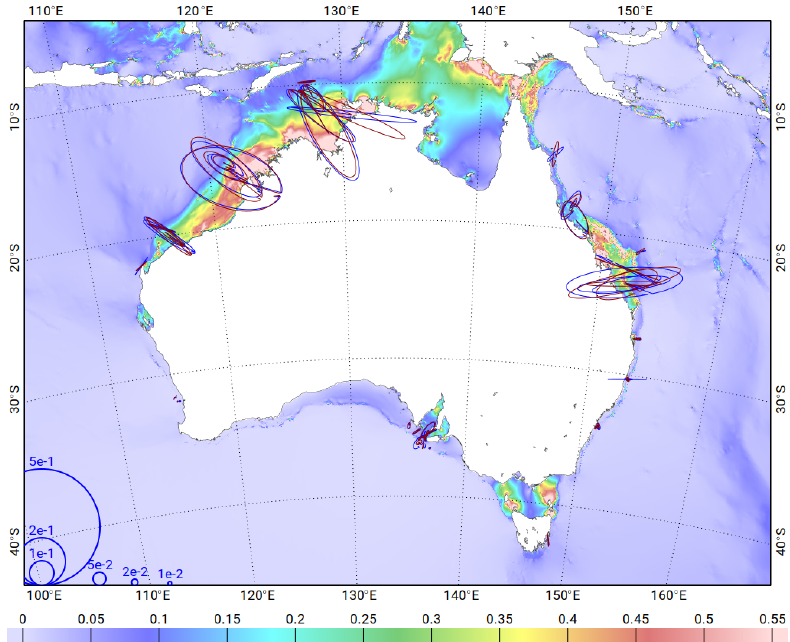
Figure 18. M2 tidal component, tidal velocity ellipses at the 48 current meter stations around Australia for the FES2014b tidal model (blue) and the ADCP observations (red). Ellipse scales are in ms − 1 . The inside line indicates velocity direction at Greenwich transit time, ellipse rotation from inside line to arrow-terminated ellipse contour.